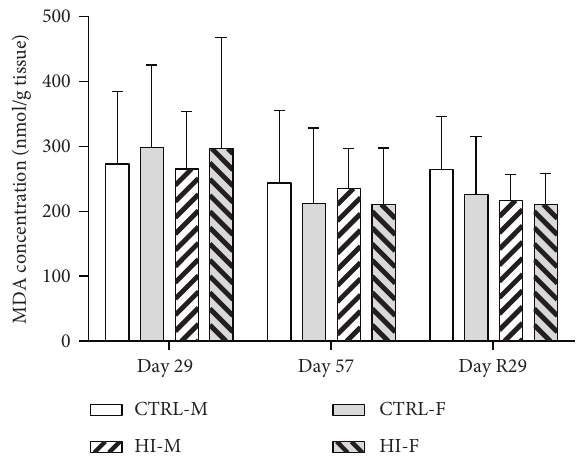
Figure 4: MDA concentration in brain tissue, mean +SD. CTRL-M: n = 7 − 10 , HI-M: n = 5 − 7 , CTRL-F: n = 8 − 9 , and HI-F: n = 6 − 9 . Statistical analysis showed no e ff ect of HI-dosing or sex at any of the time